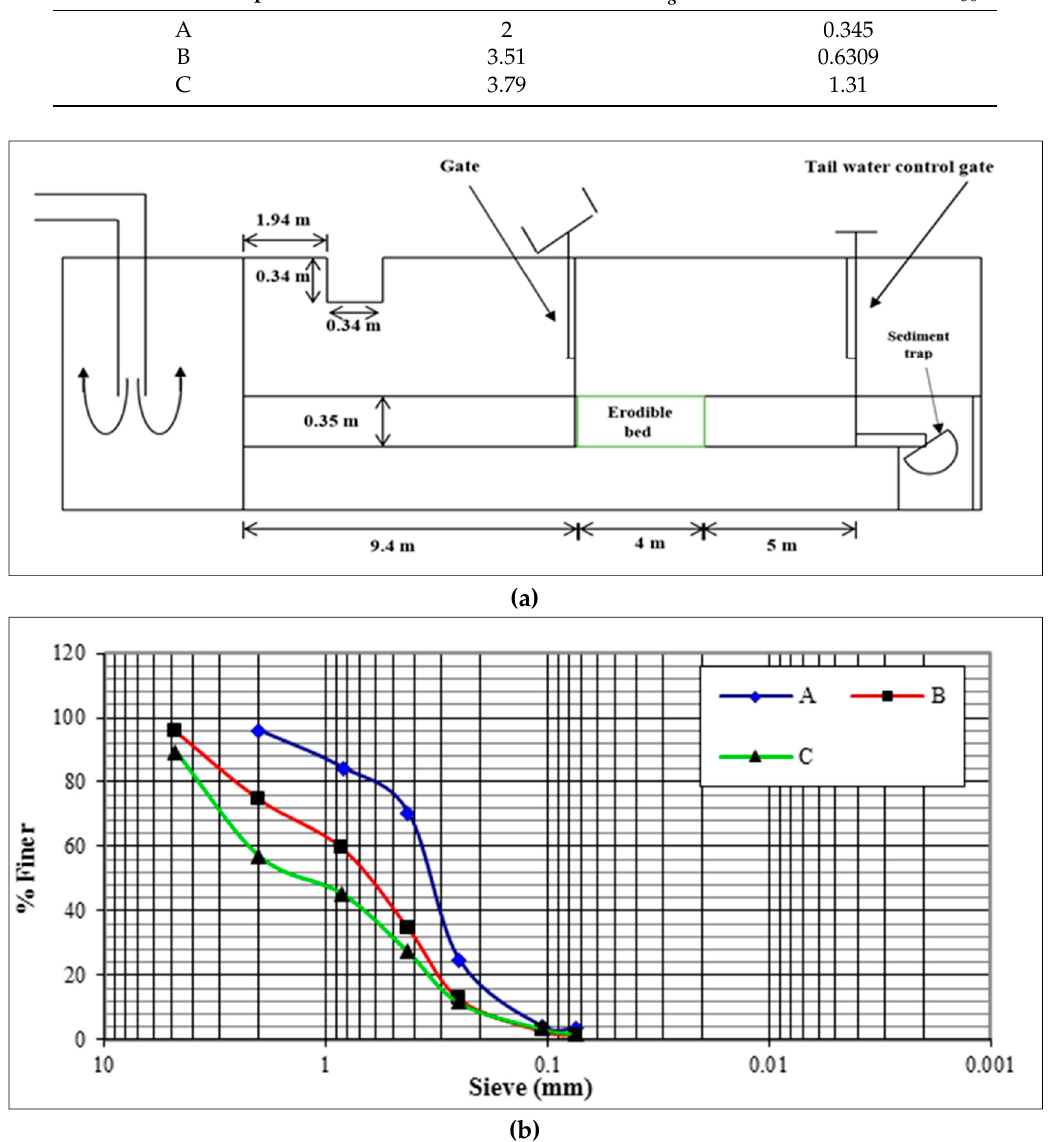
Figure 2. ( a ) Schematic diagram of the experimental setup, ( b ) Sieve analysis graphs of bed materials.